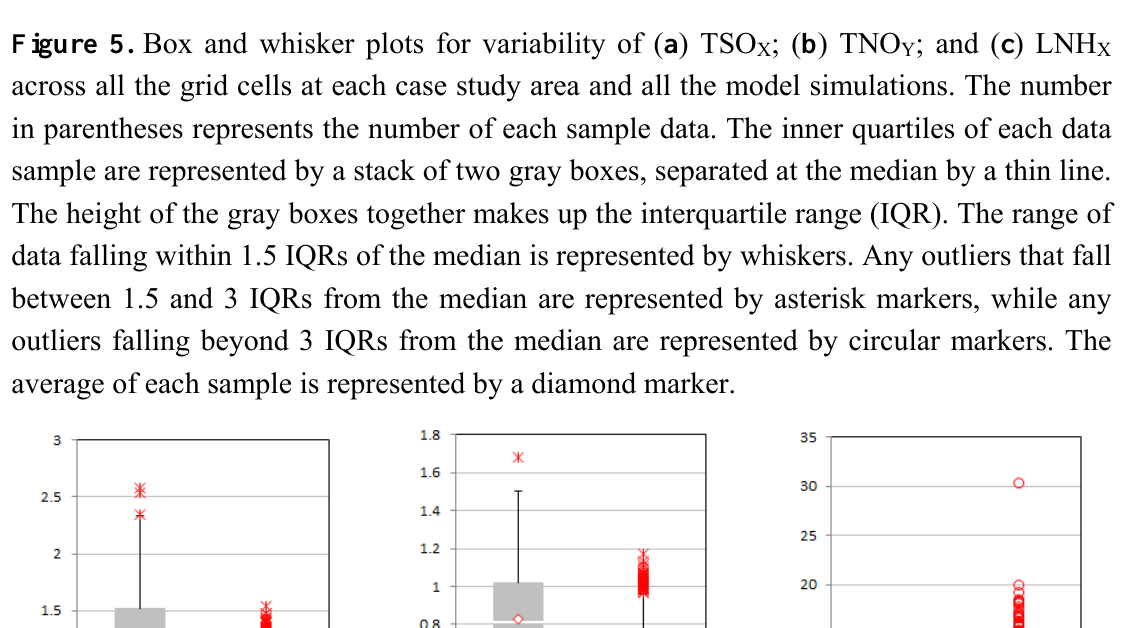
; ( b ) TNO ; and ( c ) LNH X Y X